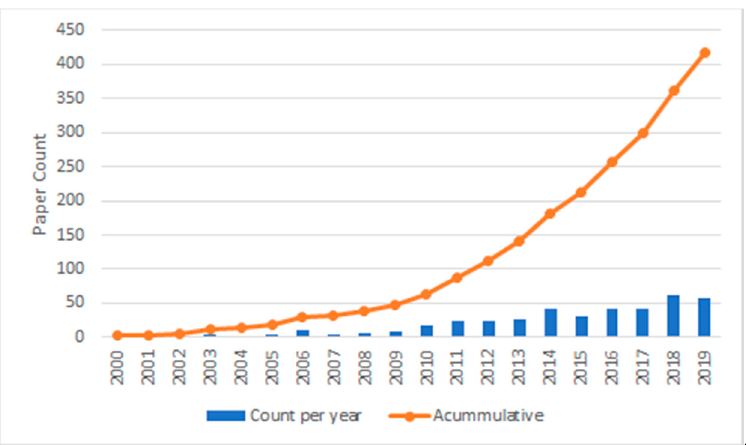
Figure 1. Hits for the concepts of “Smart Coach”, “Virtual Coach” and “Coach System” in the last 20 years in Scopus.